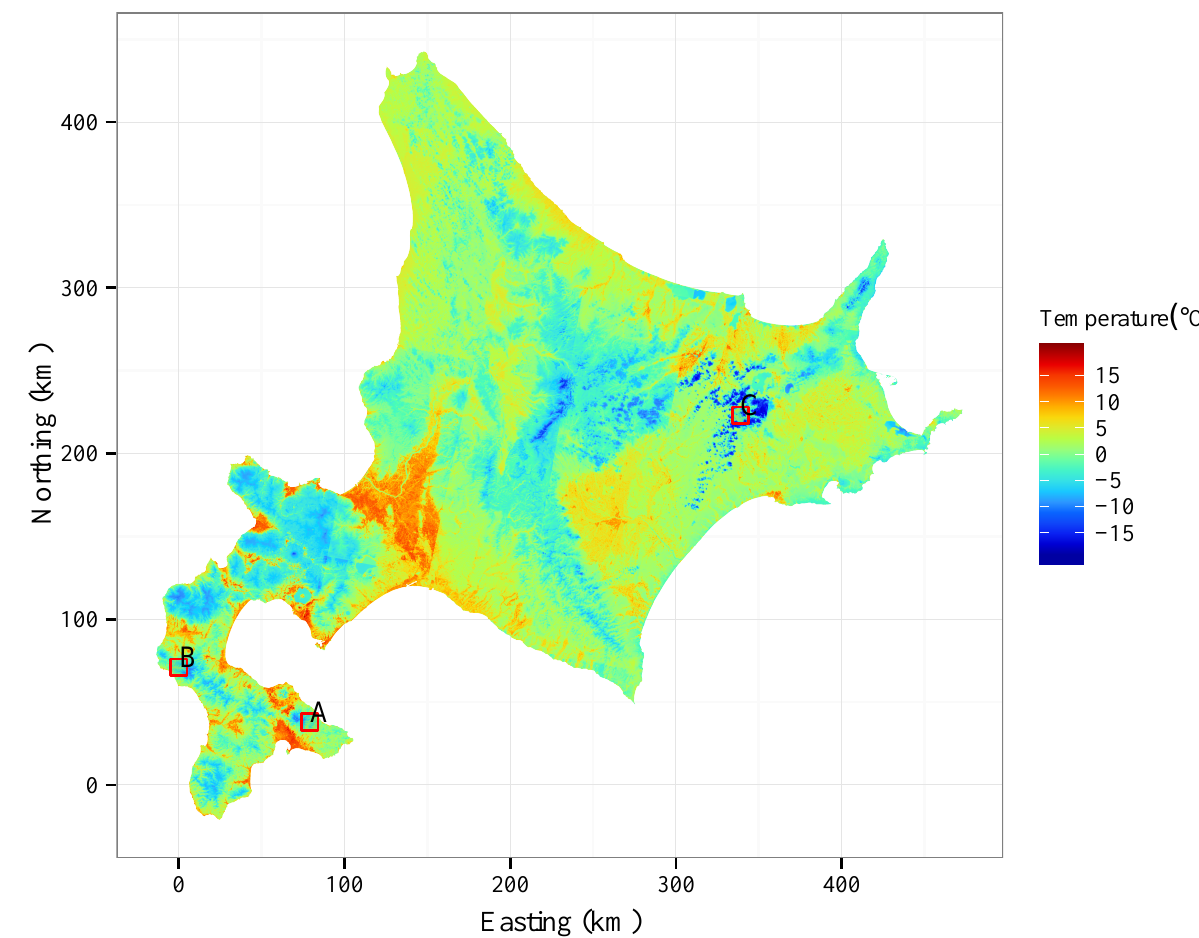
Figure 10. Land surface temperature map produced from 13 Landsat 8 Thermal InfraRed Sensor (TIRS) images and connection of each scene subtracted from the mean